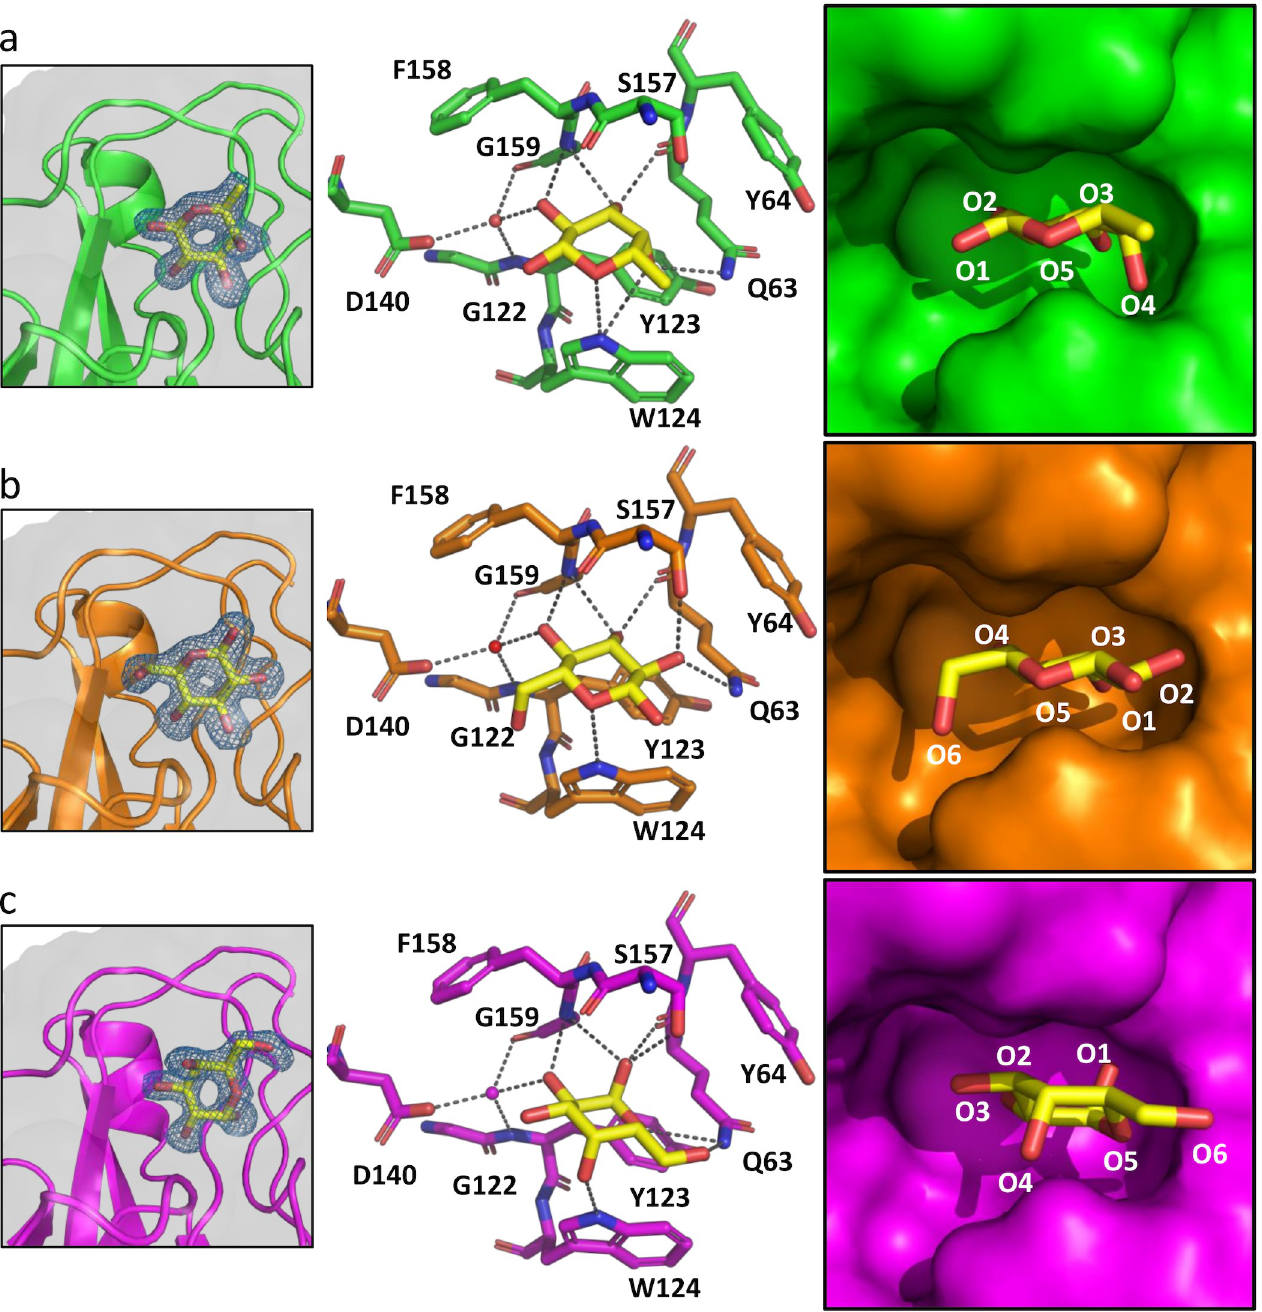
Fig 6. UcaD LD :monosaccharide complexes. Binding site details of the, a) UcaD LD :fucose, b) UcaD LD :glucose, and c) UcaD LD :galactose interactions. Left panel: Omit electron density maps of the ligands (m F o − D F c , blue mesh), contoured at 3.0 σ . Middle panel: Bound monosaccharides and the residues implicated in recognition of monosaccharides are displayed in stick representation. Interactions between the monosaccharides and residues of the binding pocket of � 3.6 Å are shown as dashed lines. Water molecules are shown as red spheres. Right panel: Surface representation of the binding sites. In the refined structure of the UcaD LD :Fuc complex, positive difference density is observed adjacent to C4 (Fig P in S1 Text) suggesting that a minor fraction of the bound Fuc molecules adopt an alternate conformation in the crystal with the C4’ hydroxyl interacting with S157. This conformation was not modelled in the deposited structure.